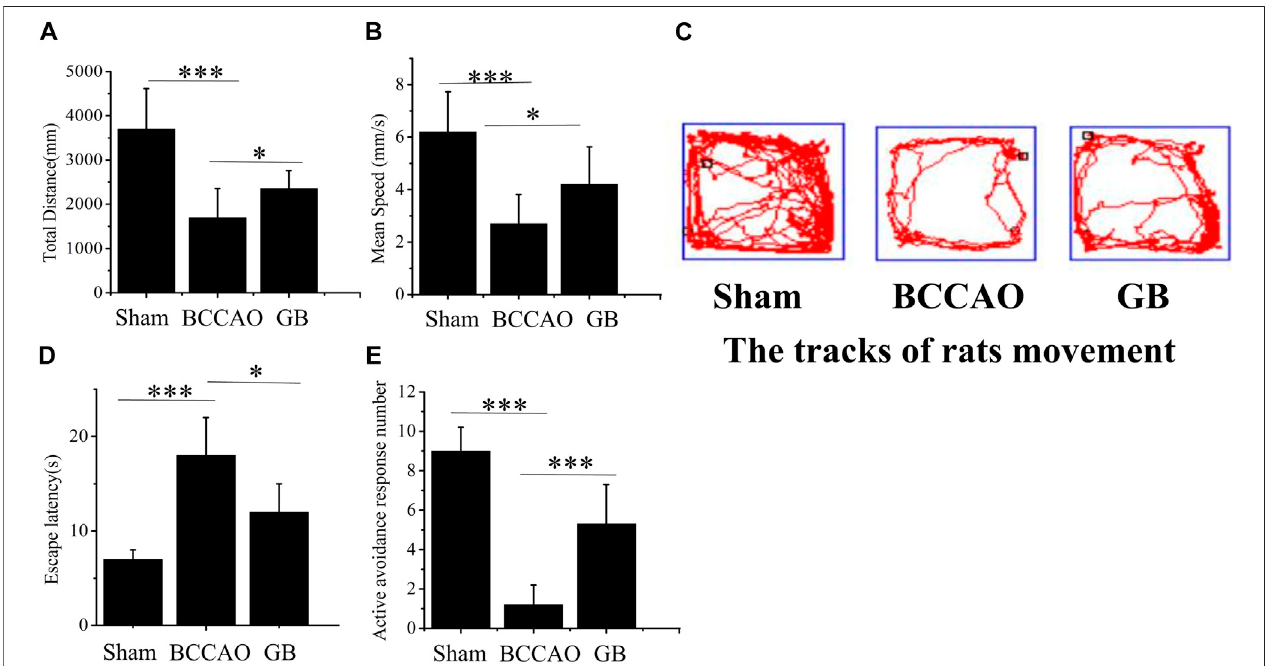
FIGURE 4 | Effects of GB on movement activity and memory ability in BCCAO rats. In open fi eld test, the change of the total distance (A) and mean speed (B) in sham group, BCCAO group and GB treated BCCAO group. Data represented the mean ± SD ( n (cid:1) 5), * p < 0.05, *** p < 0.001 (C) Track diagram ofrats movement in the Sham, BCCAO model and GB treated BCCAO groups. Y-maze test was used to analyze working memory in rats (D) Escape latencies analysis. Data represented the mean ± SD ( n (cid:1) 5), * p < 0.05, *** p < 0.001 (E) Active avoidance response number analysis. Data represented the mean ± SD ( n (cid:1) 5), * p < 0.05, *** p < 0.001.